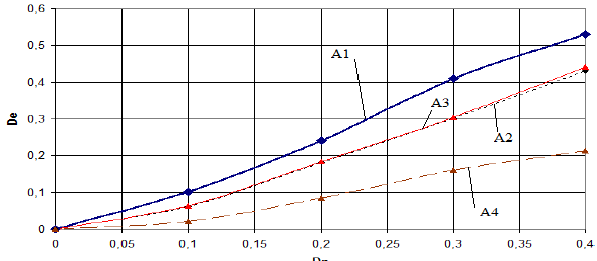
variance of the filtering error is about 80% when using all eight available spectral zones as compared with a single two- dimensional frame. Figure 3 (X-axis is Noise Variance, Y-axes is Filtering Error Dispersion) shows the dependences of the image filtering error variance on the noise variance: A1 is a Kalman vector filter without interpolation; A2 is a discrete Wiener filter, A3 is a Kalman filter with interpolation, A4 is a DSF (Vasiliev, 2018).